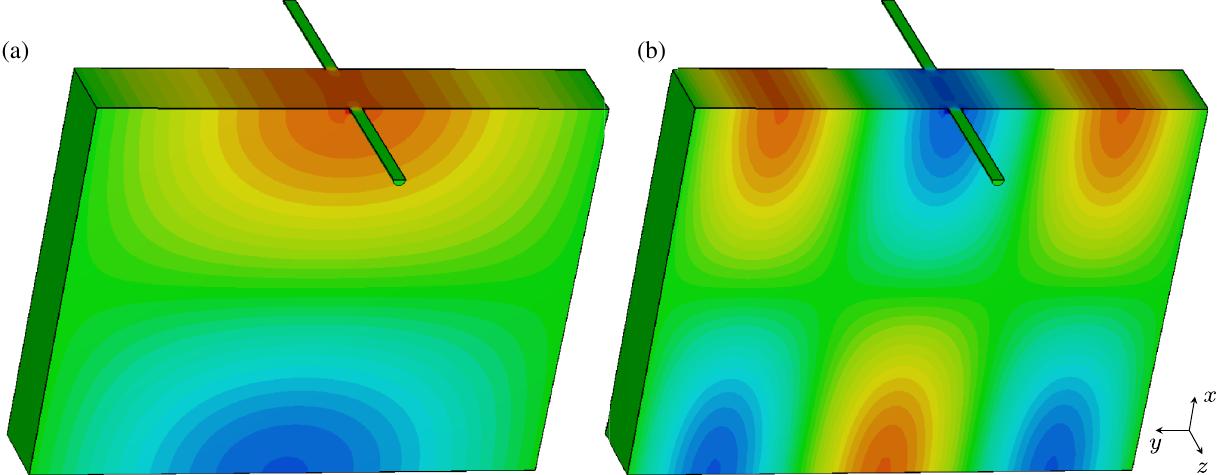
FIG. 11. Cross section of the (a) fundamental and (b) higher harmonic chopping mode cavity. Colors represent the relative field strength of the magnetic field in the y -direction with red positive and blue negative, normalized to the maximum field strength. Cavity dimensions in mm are 379 . 1 × 244 . 8 × 36 . 1